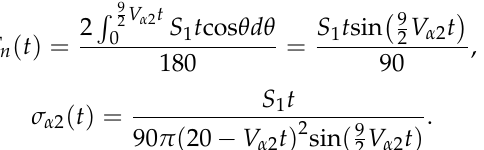
Table 6. Personal computer parameters and the simulation operation time.